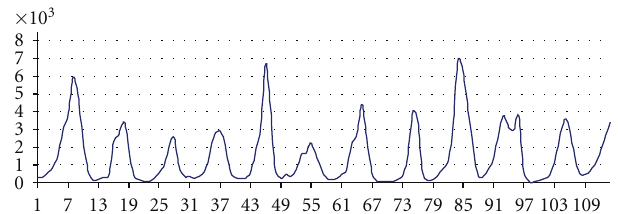
Figure 1: Canadian lynx data series